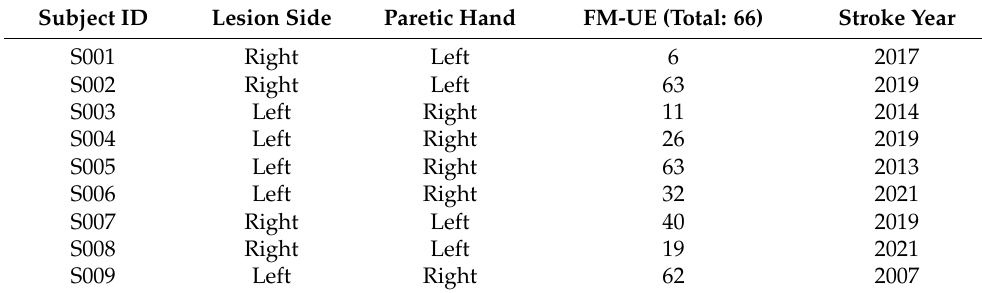
Table 1. Stroke participants’ demographics. FM-UE: Fügl–Meyer upper extremity scores.